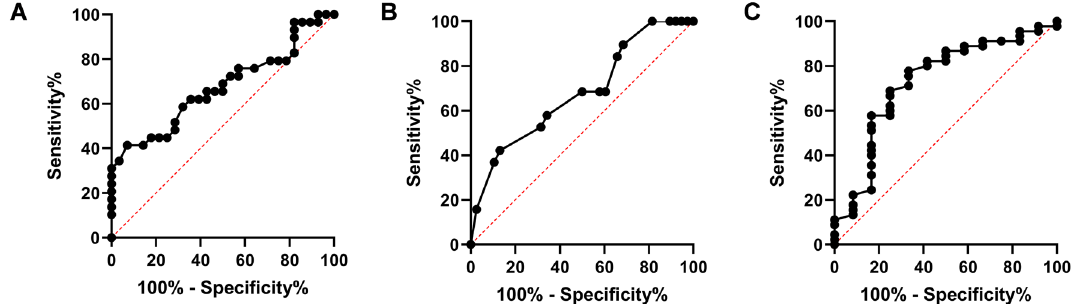
Figure 3. ( A ) ROC curve of GMFM-66 scores in cases with reduced bladder capacity (AUC: 0.67; CI 0.53–0.81; p = 0.03; cut-off point: 70.22, sensitivity: 41.38%, specificity: 92.86%). ( B ) ROC curve of age in cases with DO (AUC: 0.68; CI 0.53–0.83; p = 0.03; cut-off point: 4.75 years old, sensitivity: 42.11%, specificity: 86.84%). ( C ) ROC curve of SAIR threshold in cases with elevated PVR (AUC: 0.73; CI 0.56–0.90; p = 0.02; cut-off point: 0.72 mA, sensitivity: 77.78%, specificity: 66.67%). ROC receiver operating characteristic, GMFM-66 gross motor function measurement-66, AUC area under curve, DO detrusor overactivity, SAIR sphincter-associated input roots (rootlets), PVR post-voiding